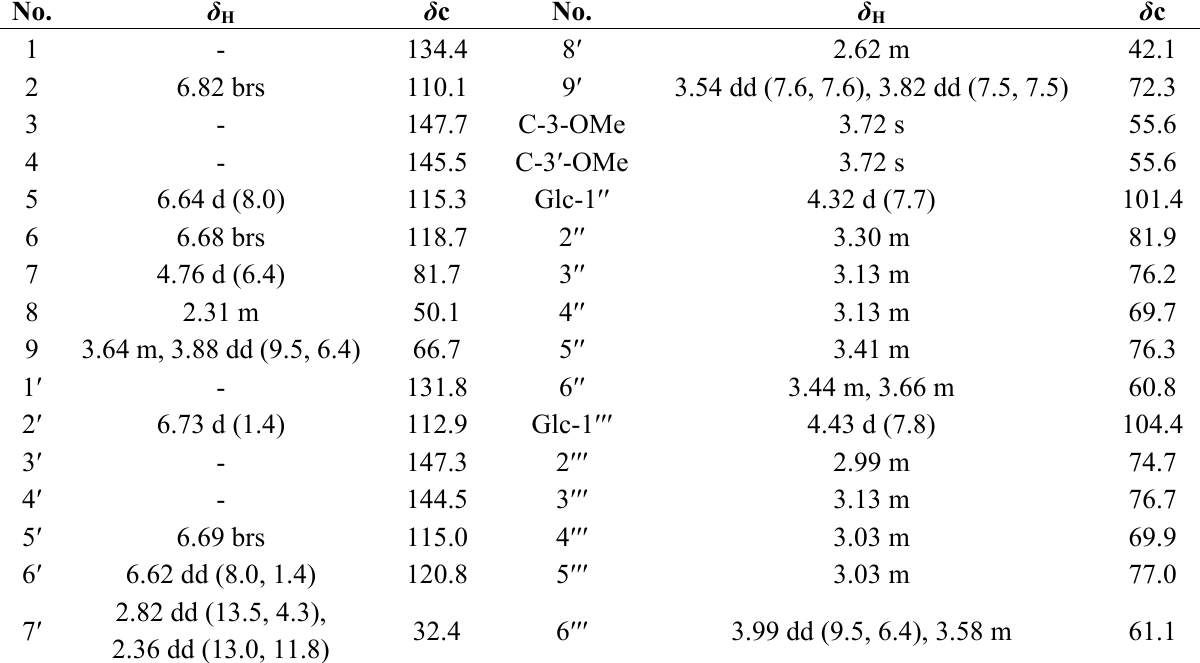
OD, δ in ppm, J in Hz). 3